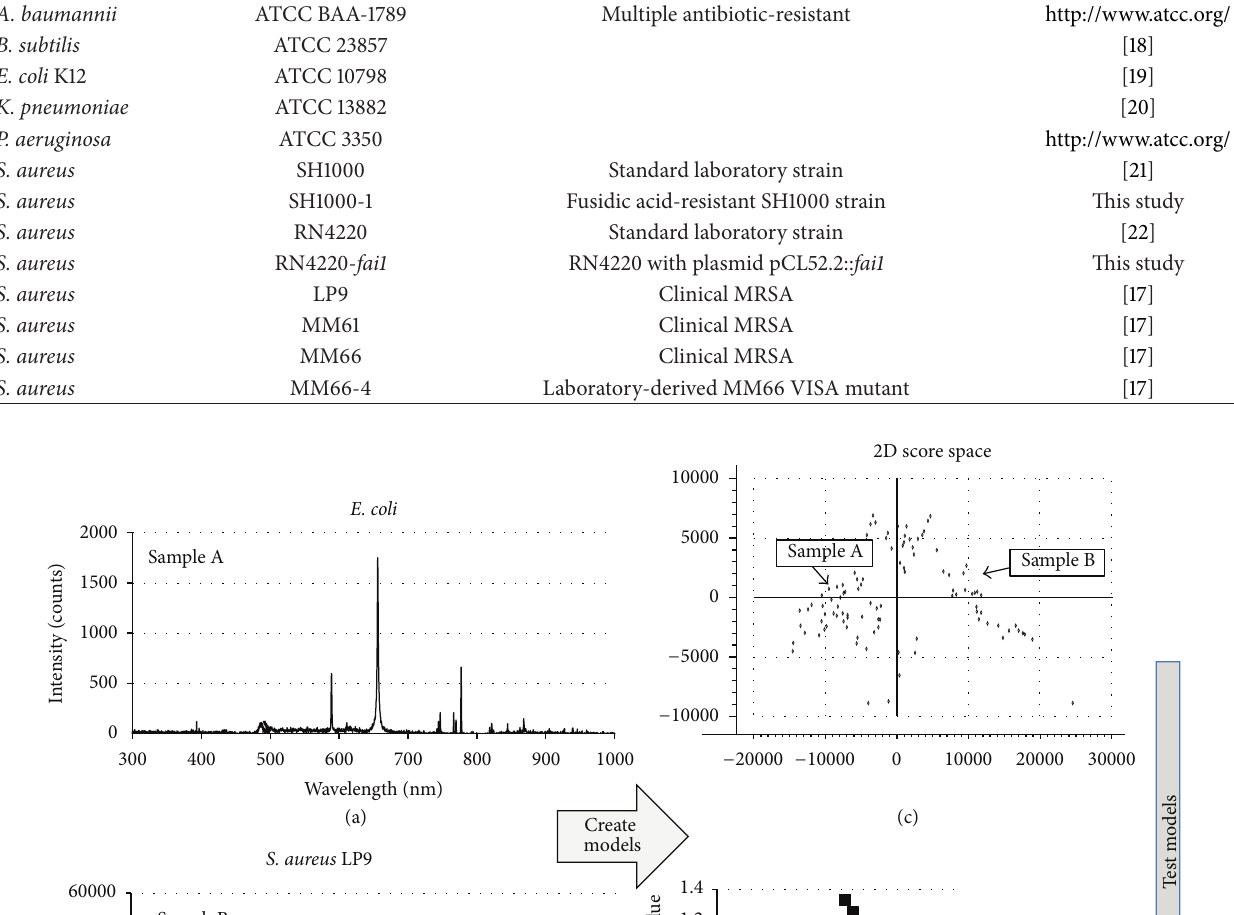
were collected from each sample. Representative spectra for E. coli and S. aureus are shown in Figures 1(a) and 1(b). Of